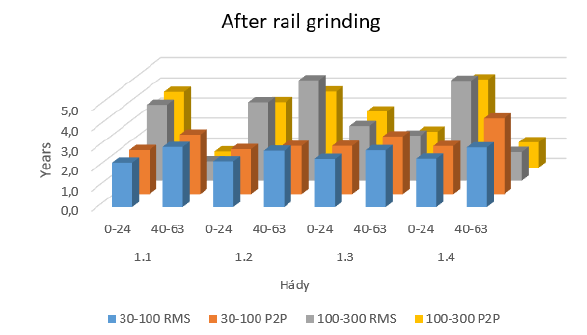
Figure 4. Number of years needed to reach the wave defect progression of the same level as before the rails replacement.